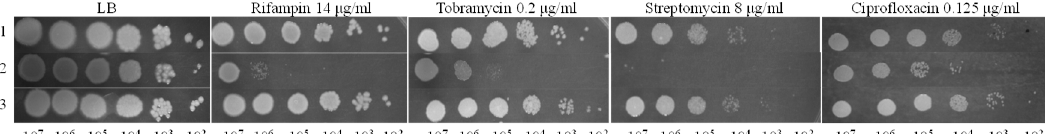
Figure 4. Comparison of antibiotic susceptibilities among PAO1, topA -RM and the complementation strain. The growths of the three strains on different antibiotics are shown. Row 1, PAO1 with pUCP26 (the empty plasmid); row 2, topA -RM with empty vector pUCP26. The colonies appear darker due to PYO over-production; row 3, topA -RM complemented by an intact topA carried on pUCP26. Serial dilutions are shown underneath. The LB plate on the left contained no antibiotics.